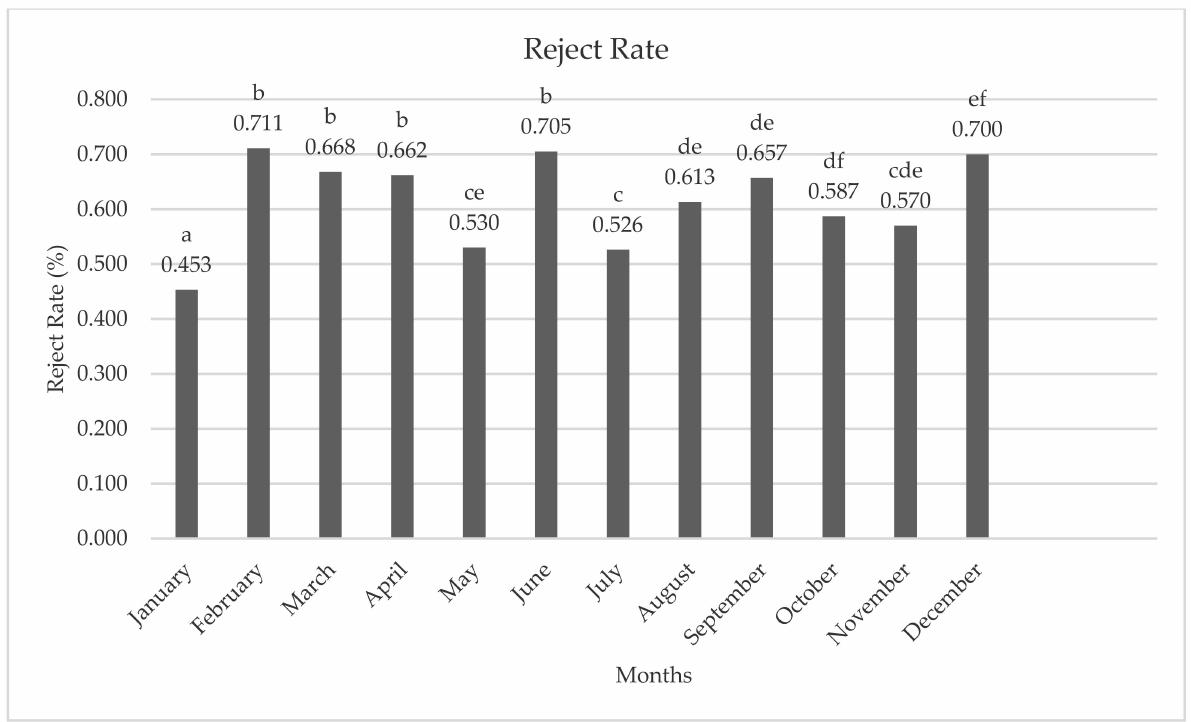
Figure 4. Average reject rate of hens according to months. a – f ; different letters indicate statistical